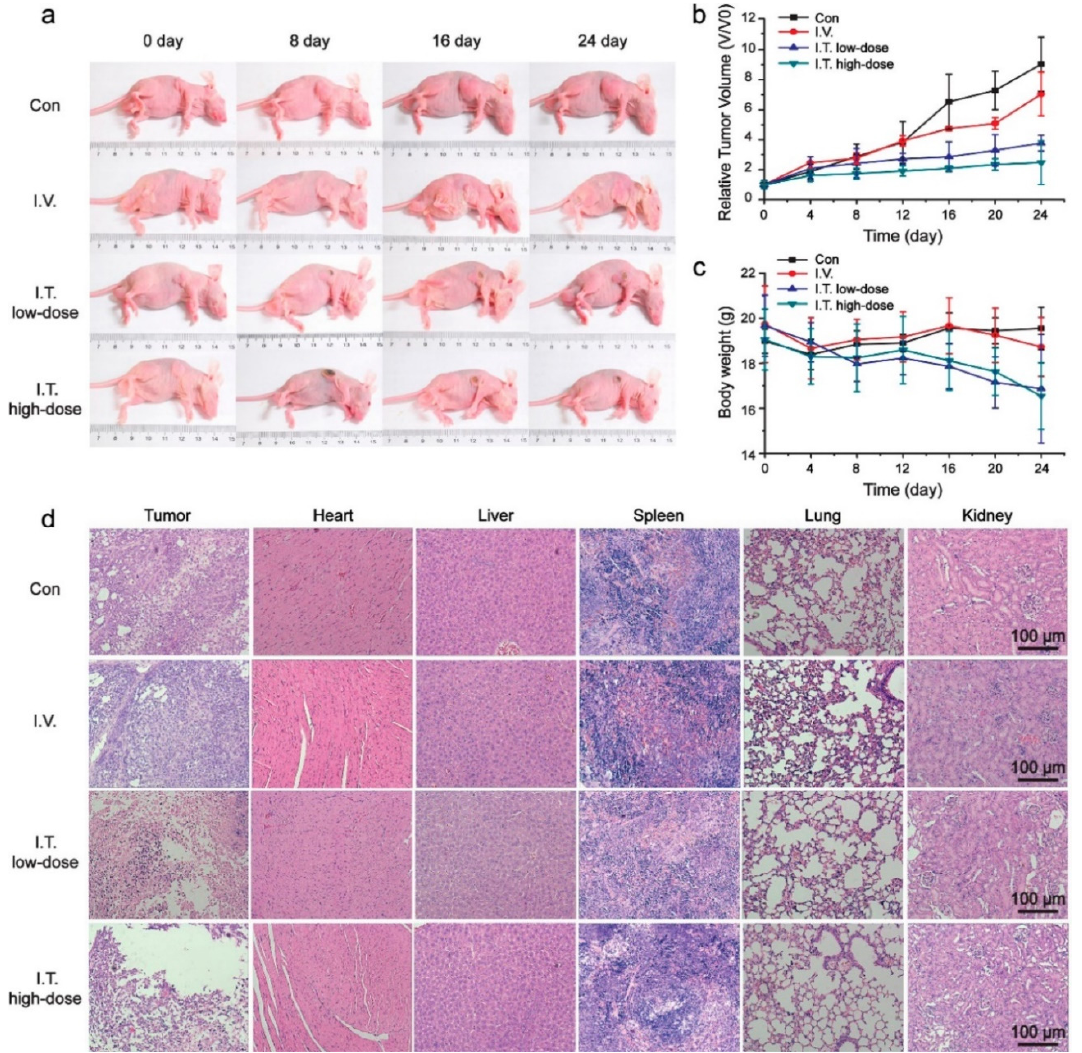
Figure 6. In-vivo photodynamic effect of Ce6-doped Pdots. ( a ) representative photographs for tumor-bearing nude mice during PDT. Relative tumor volume (V/V0) ( b ) and body weight ( c ) of tumor-bearing nude mice in control group (Con), intravenous injection group (I.V.), intratumoral injection low-dose group (I.T. low-dose) and intratumoral injection high dose group (I.T. high-dose). ( d ) Histopathology analysis of tumors and organs collected from tumor bearing nude mice after PDT. (Reprinted Permission American Chemical Society, 2017)